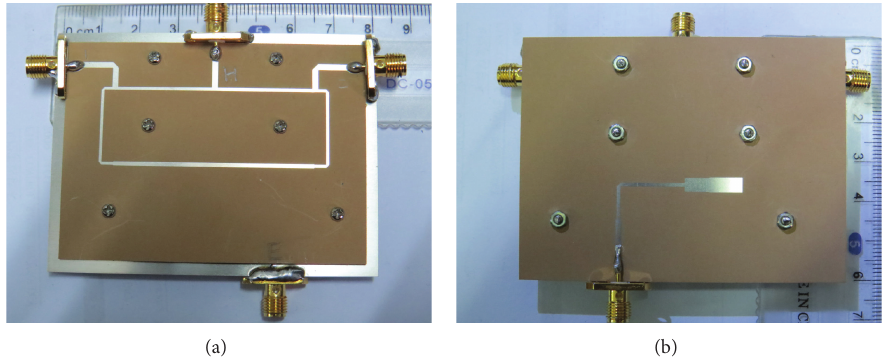
Figure 6: Photograph of the improved magic-T. (a) Top view. (b) Bottom